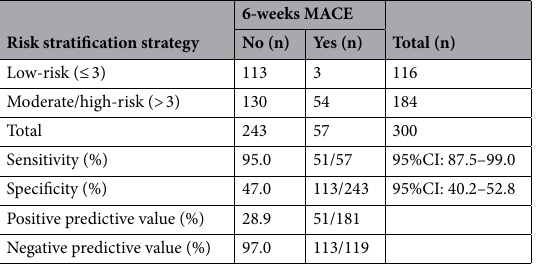
Table 5. Performance characteristics of HEART risk stratification strategy. MACE Major adverse cardiovascular